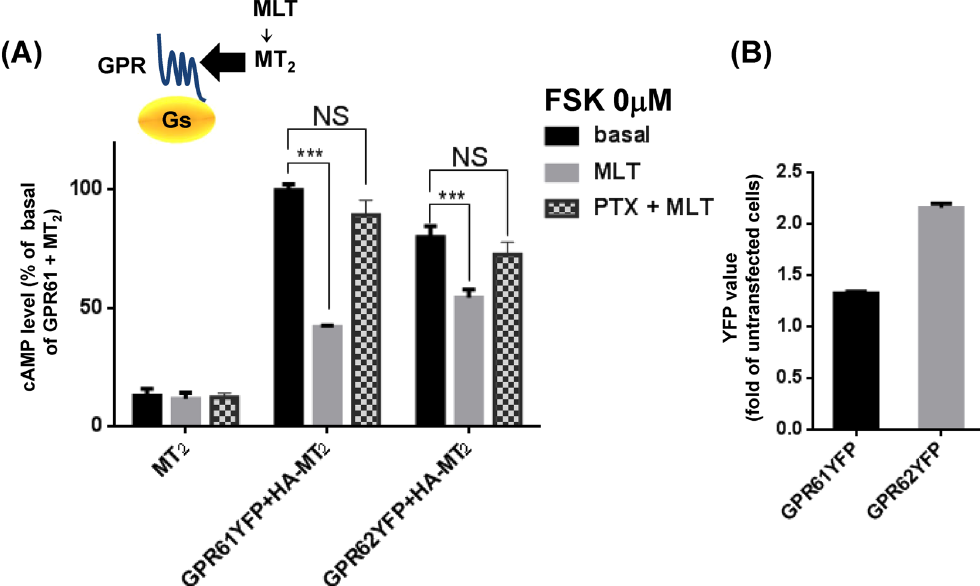
Figure 7. Inhibition of constitutive G s /cAMP signaling of GPR61 and GPR62 by MT 2 . ( A ) HA-MT 2 was expressed in HEK293T cells alone or together with GPR61-YFP or GPR62-YFP and cAMP levels determined in untreated and melatonin-treated (1 µ M, 30 minutes) cells. Some cells were pre-treated with pertussis toxin (200 ng/ml × 4 hr) pretreatment. ( B ) Expression levels of GPR61YFP and GPR62YFP were determined in parallel by measuring YFP fluorescence. Data are expressed as mean ± SEM from at least 3 independent